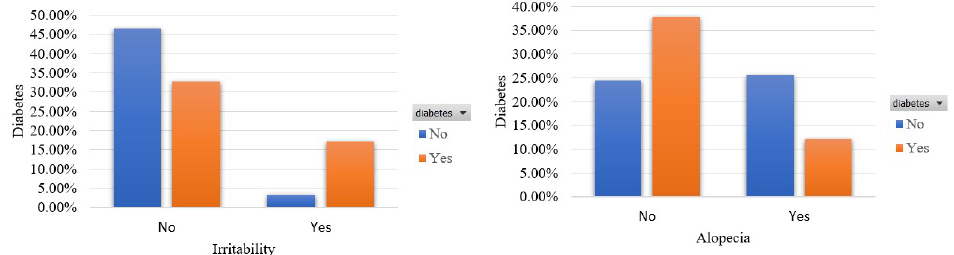
Figure 5. Participants’ distribution in terms of irritability and alopecia in the balanced